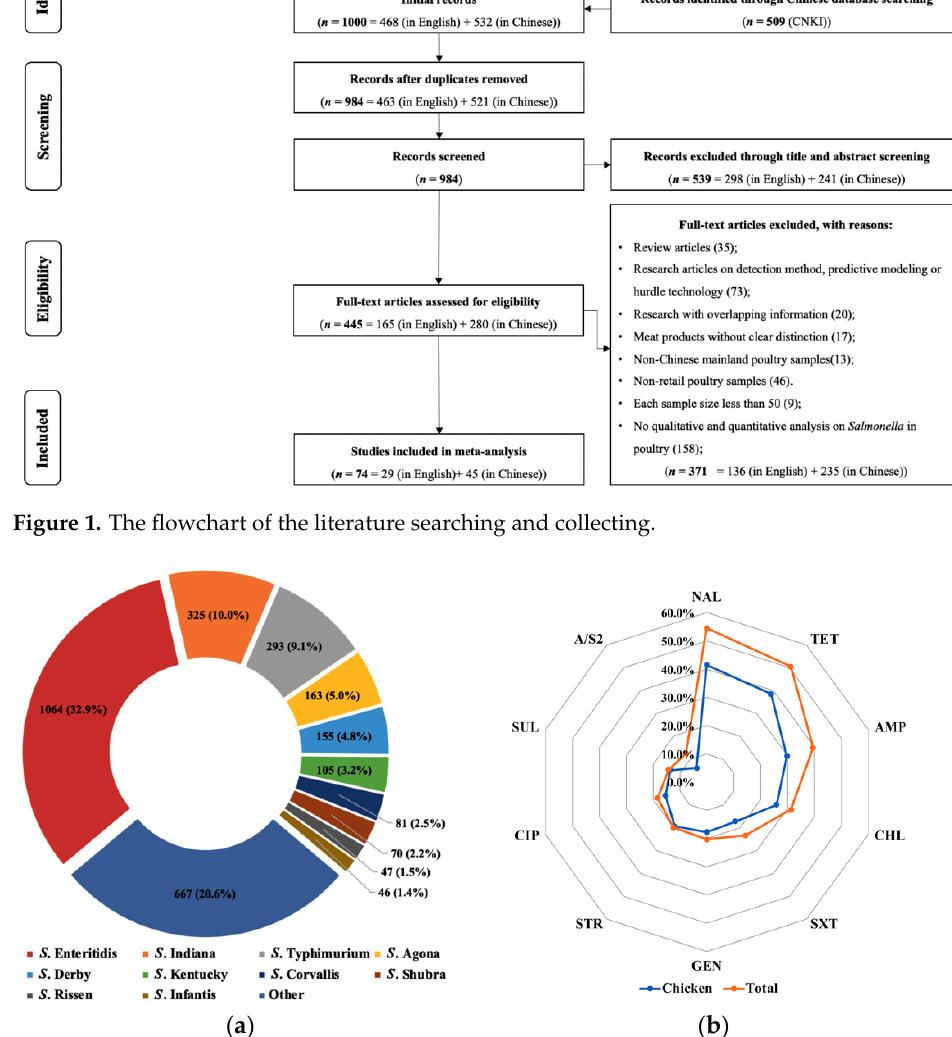
Figure 2. Serovar distribution ( a ) and antimicrobial resistance ( b ) of Salmonella strains isolated from Chinese retail raw poultry meat.